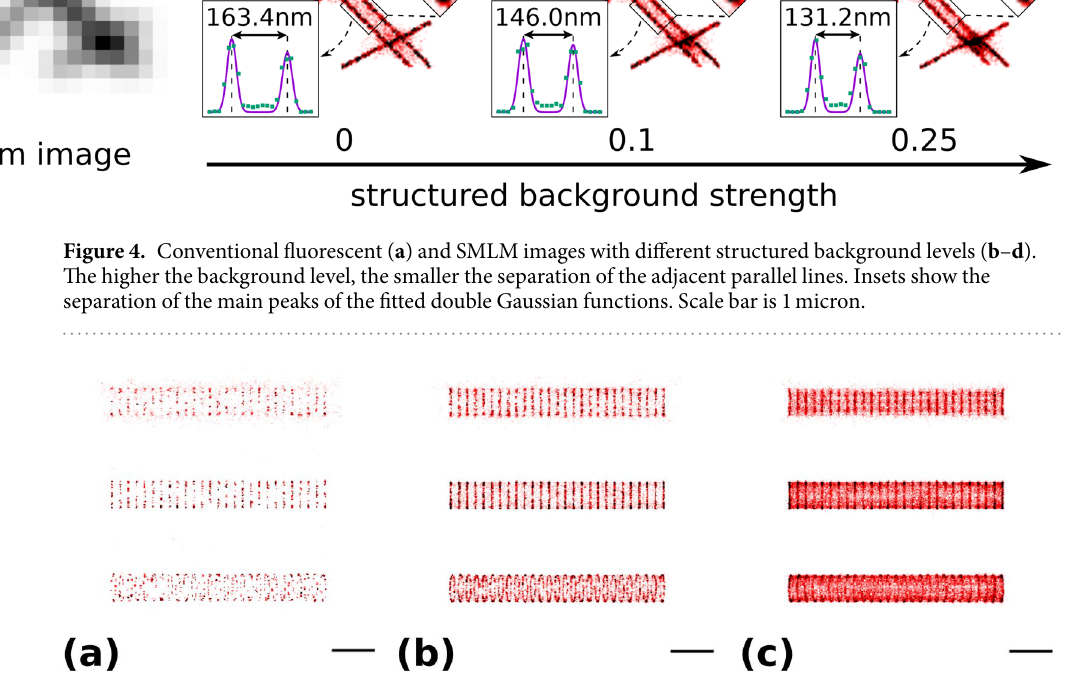
Figure 5. Axon segments at 10 dyes/ μ m ( a ), 50 dyes/ μ m ( b ) and 200 dyes/ μ m ( c ) labelling density values. Scale bar is 1